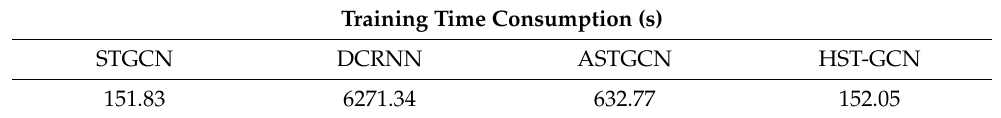
Table 3. Training time